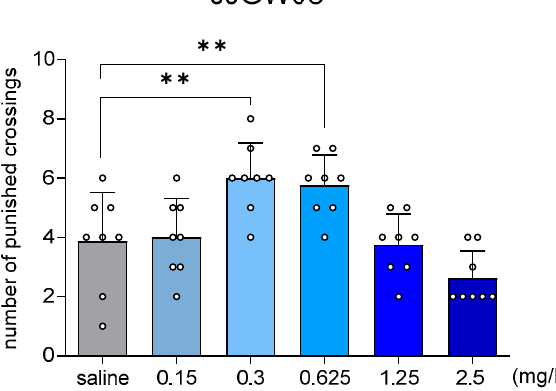
Figure 2. The effect of JJGW08 on the number of punished crossings in the four-plate test. Mice were placed in the apparatus, and after a 15 s adaptation period, each mouse crossing from one plate to another was punished with an electric shock. JJGW08 was administered intraperitoneally ( ip ) 30 min before the test. The control group received 0.9% NaCl solution ( ip ). Values are expressed as means ± SD, n = 8–10 mice per group. Statistical analysis: one-way ANOVA (Newman–Keuls post hoc ), ** p < 0.01.